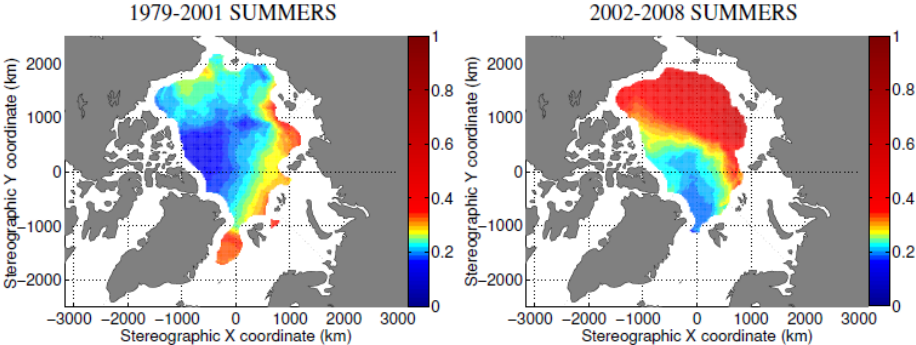
Figure 9. Spatial distribution of the magnitude of inertial oscillations in Arctic sea ice in summer in (a) 1979–2001 and (b) 2002–2008. The colour scale presents a non-dimensional parameter that Gimbert et al. (2012a) calculated to represent the magnitude of inertial oscillation. Reproduced with permission from Gimbert et al. (2012a).